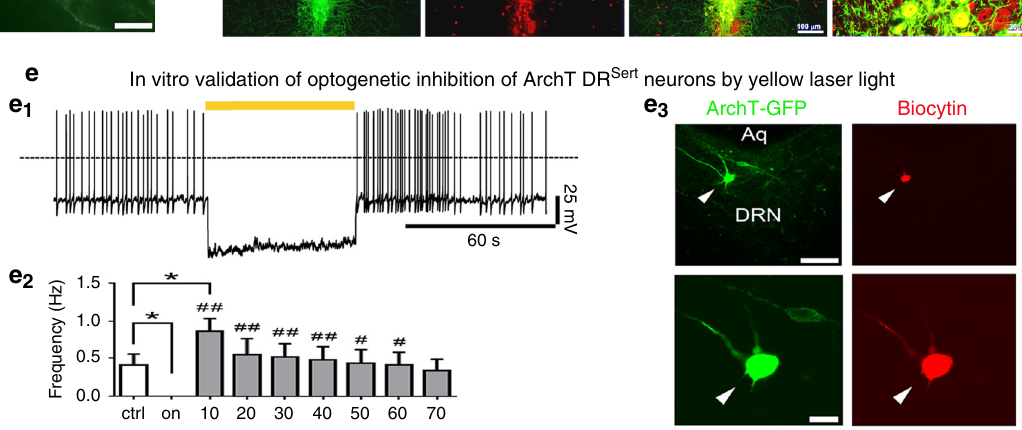
Fig. 4 Optogenetic silencing of the DR Sert neurons. The experimental strategy for acute silencing of the DR Sert neurons ( a ) involved expressing the inhibitory opsin ArchT selectively in the DR Sert neurons, by injecting AAV-Flex-ArchT-GFP in the DR of Sert-Cre mice. Photomicrographs in b show the histological validation of ArchT transduction ( n = 6) in the DR Sert neurons at two rostral-to-caudal levels, and their relationship with the tip of the optical fi ber targeting the ArchT-DR Sert cells (the fl at fi ber tip rested on the fl oor of the cerebral aqueduct; its position is marked by a dotted line and an arrow). To validate that ArchT is expressed only in the serotonin cells ( n = 6), c1 and c2 show photomicrographs from a brain section labeled for both GFP (ArchT- green) and serotonin (red); and merged (double labeling is yellow) showing that nearly all the ArchT-expressing cells were serotoninergic. The fourth panel in both c1 and c2 are the same sections represented at higher magni fi cation. Panel a shows a drawing of the mouse brain at the level of the mid-DR (equivalent to plane − 4.6 mm from bregma, of the mouse brain atlas) 53 . d – e In vitro brain slice recordings from a DRN ArchT-GFP neuron ( d ) photographed under IR-DIC (top) and under fl uorescence optics (bottom; scale bar: 25 µ m). e1 Exposure to 593 nm light (60 s duration) hyperpolarized and silenced action potential fi ring of DR Sert neurons expressing ArchT. e2 Bar histogram graph representing the mean fi ring frequencies before (crtl), during (on) and after (10 – 70 s; 10 s bins) photoinhibition. One-way ANOVA, F = 7.11; p < 0.0001 n = 6; Holm – Sidak ’ s multiple comparisons post hoc test; * P = 0.038 ctrl vs light-on; * P = 0.014, ctrl vs 10 s Light-OFF; ## P < 0.01 and # p < 0.05 Light-ON vs Light-OFF. Data in e2 are presented as mean values ± SEM. e3 Post hoc intracellular biocytin labeling (red with streptavidin-AF-555 in right top panel) of a recorded DRN neuron that expresses ArchT-GFP (green), at low magni fi cation (top left panel; scale bar: 100 µ m) and at higher magni fi cation (bottom; scale bar: 20 µ m). The results shown in d and e3 were reproduced in n = 6 cells that were recorded from two